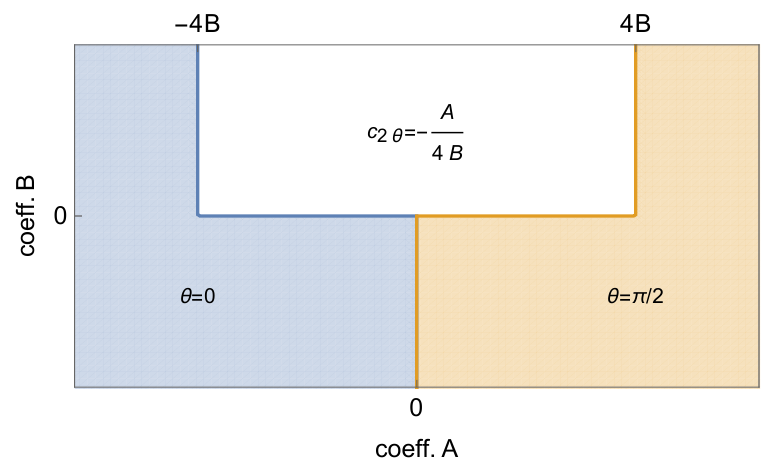
Figure 1 . Phase space of the vacuum misalignment as a function of the two coe(cid:14)cients of the potential A and B . In the blue region the EW symmetry is unbroken, in the orange one the theory is in the Technicolor vacuum, while non-trivial values of (cid:18) are obtained in the white